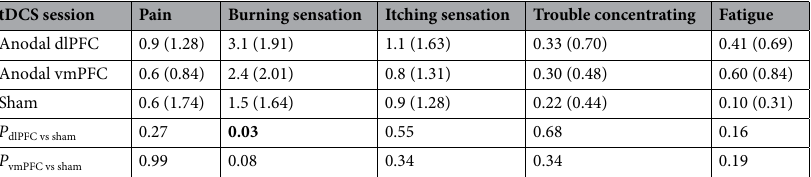
Table 1. Reported side effects during tDCS. Shown are the mean intensities of reported side effects, with standard deviations in brackets. tDCS = transcranial direct current stimulation; dlPFC = dorsolateral